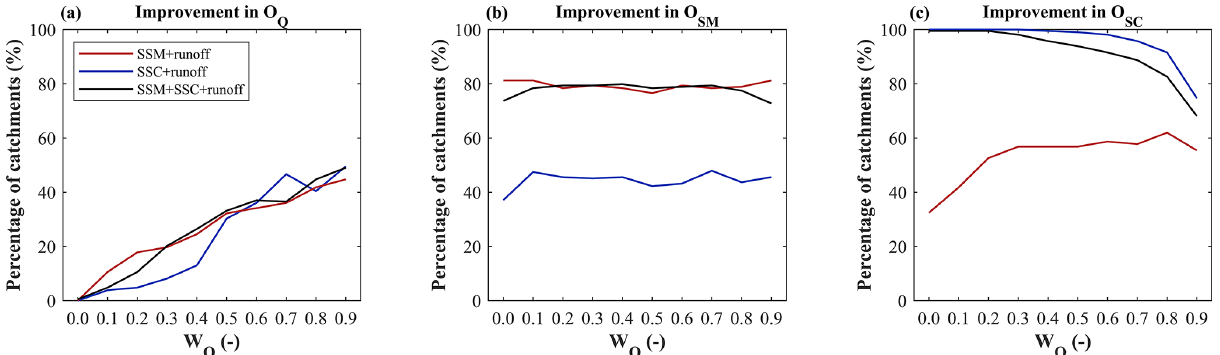
Figure 10. Relative number of catchments with improvement in runoff (a) , soil moisture (b) , and snow cover (c) model efficiency in the validation period. Relative number relates to the 213 Austrian catchments used in this